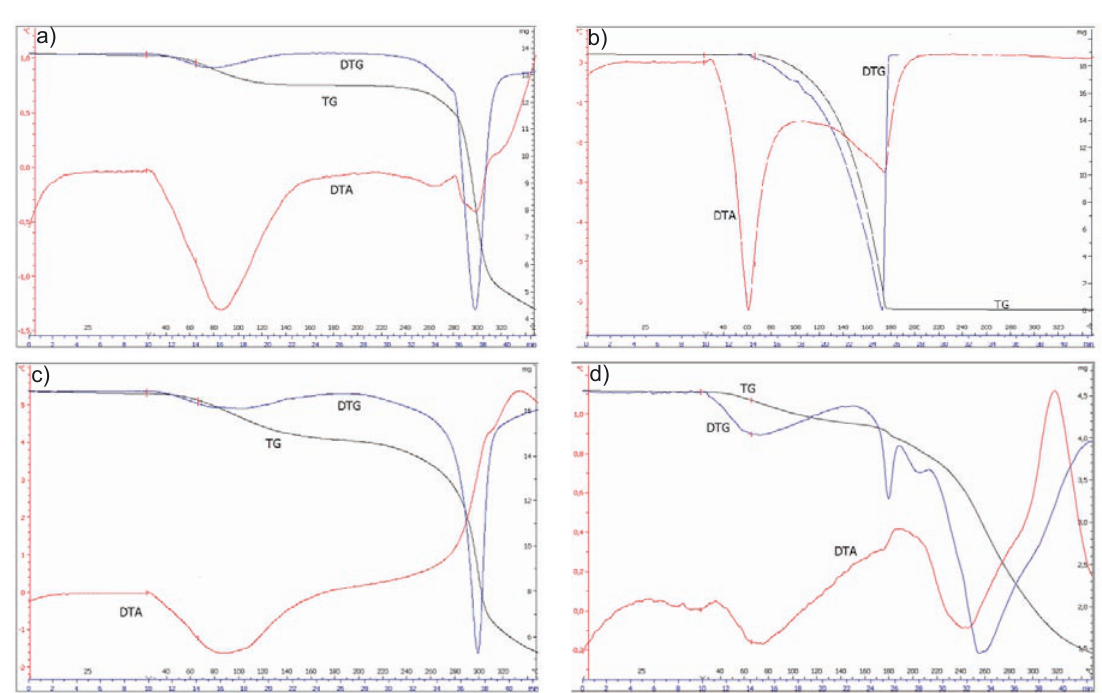
Figure 2. Thermal curves (DTA, DTG, TG) of a) maltodextrin; b) hexamethylene diamine (HMD); c) physical mixture of maltodextrin and HMD (1:1 molar ratio) and d) HMD-modified maltodextrin. Al crucible, static air atmosphere, 5°C min -1 heating rate